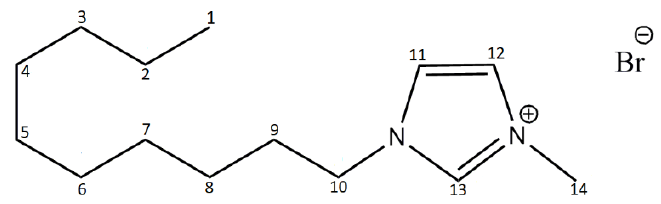
Figure 16 . Structural formula of DmiBr with marked carbons.